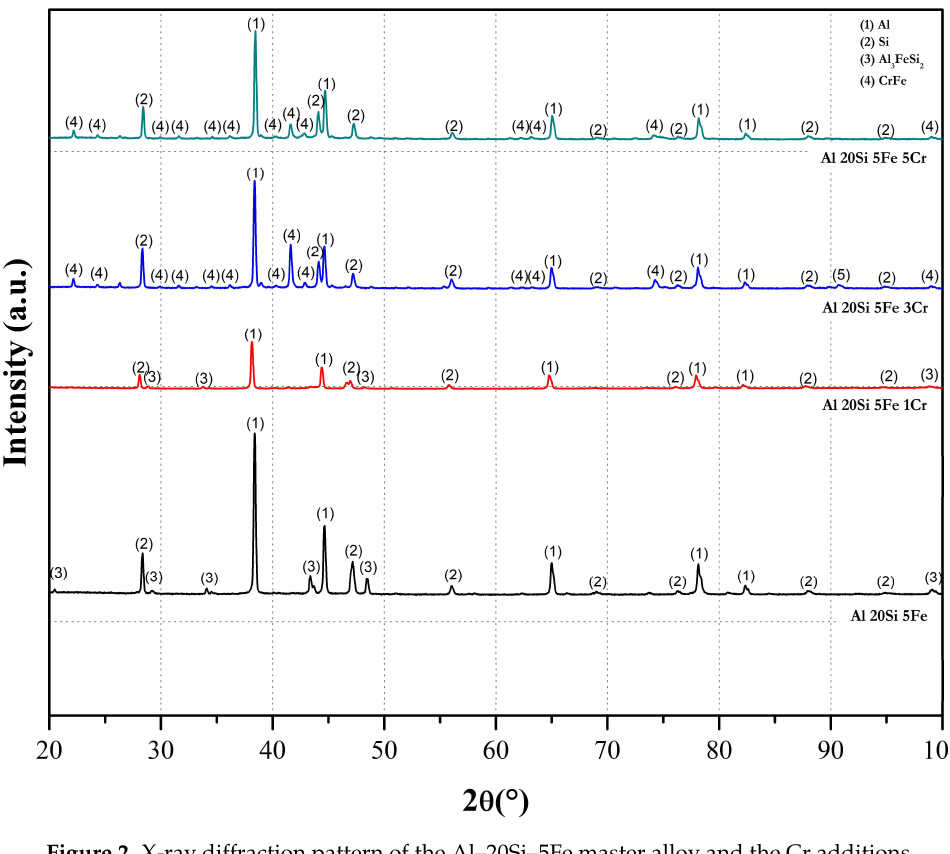
Figure 2. X-ray diffraction pattern of the Al–20Si–5Fe master alloy and the Cr additions.